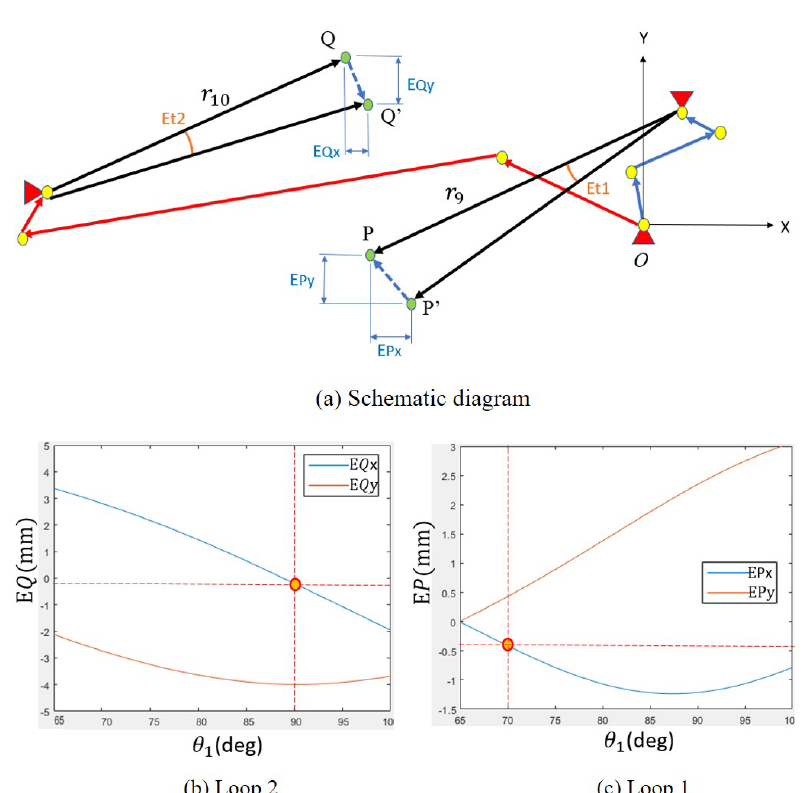
Figure 9. Output position errors of points P and Q